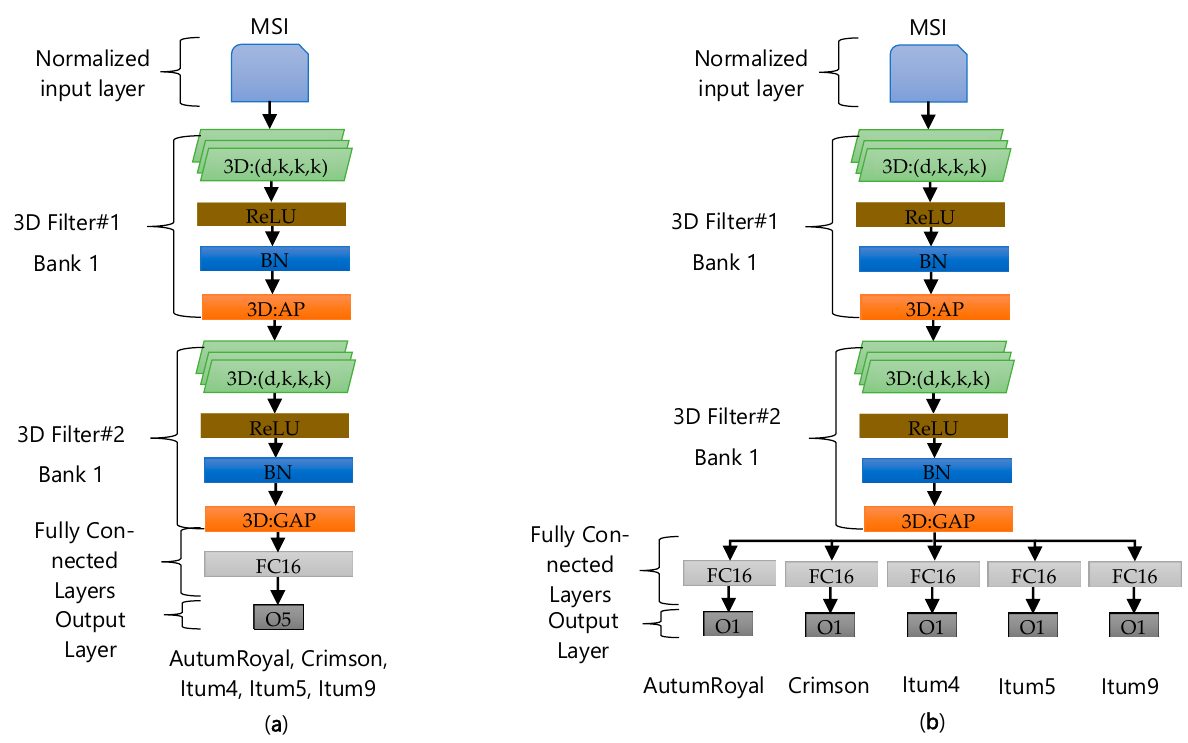
Figure 12. Proposed architectures with ( a ) single-branch output (SBO) and ( b ) multiple-branch output (MBO).